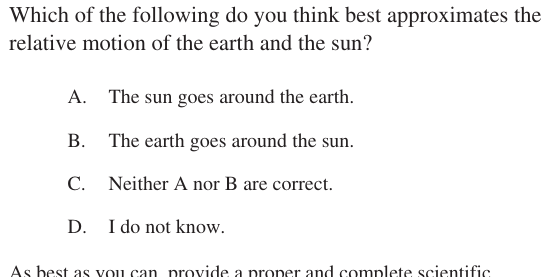
FIG. 1. Pretest and post-test given at the beginning and end to all students of the summer enrichment program and to all participants of the preservice immersion